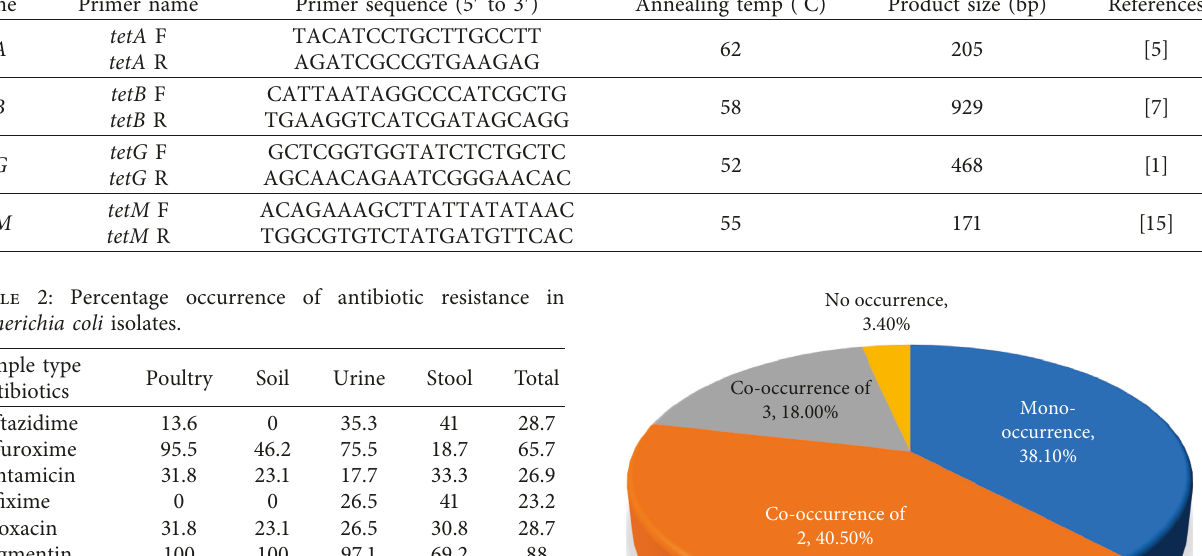
Table 1: Primer sequences for the detection of E. coli tetracycline-resistant gene fragment detection. Gene